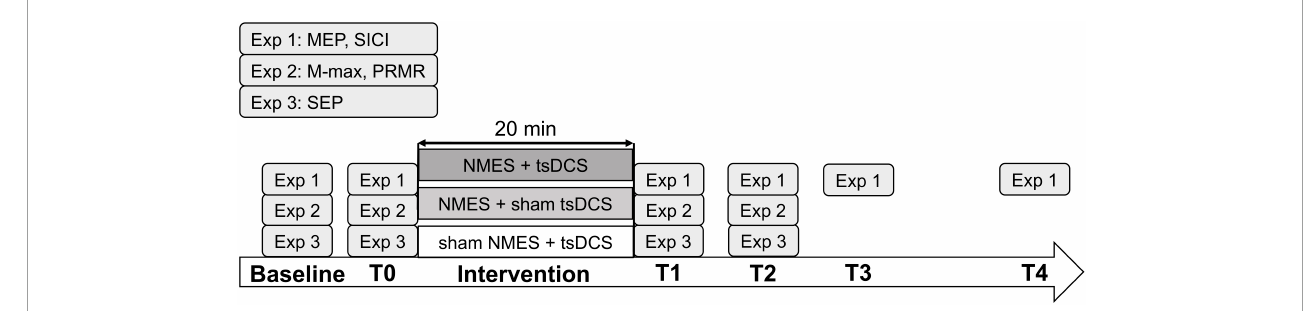
FIGURE1 Experimental procedure. The participants received neuromuscular electrical stimulation (NMES) + transcutaneous spinal direct current stimulation (tsDCS), NMES + sham tsDCS, or sham NMES + tsDCS (experiments 1, 2, and 3, respectively) in 20 min session conducted on different days. In experiment 1, motor evoked potentials (MEPs) and short-interval intracortical inhibition (SICI) were measured at baseline, before the intervention (T0), and after the intervention at 0 min (T1), 15 min (T2), 30 min (T3), and 60 min (T4). In experiment 2, maximum M-wave (M-max) and posterior root muscle reflex (PRMR) were measured at baseline, T0, T1, and T2. In experiment 3, somatosensory evoked potentials (SEPs) were measured at baseline, T0, T1, and